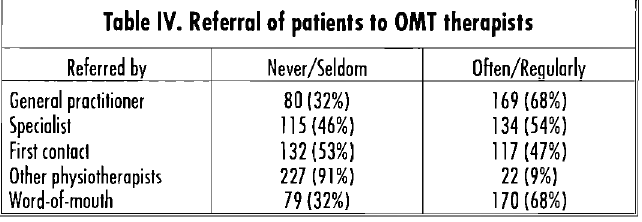
Table IV. Referral of patients to OMT